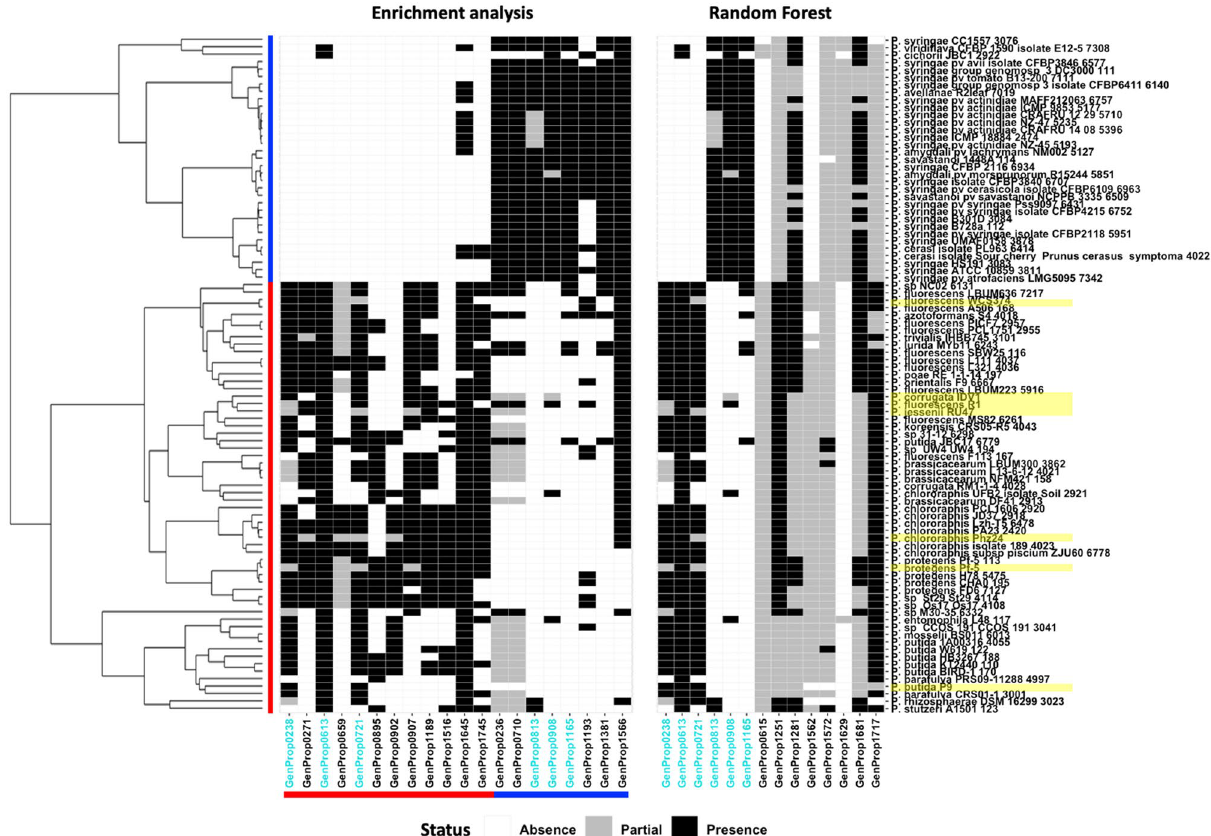
Figure 4. Representative list of discriminating Genome Properties obtained with the GP-SND approach. Left panel: enrichment analysis, right panel: Random Forest feature selection. Red lines indicate the PGPR strains (vertical) and enriched traits (horizontal). Blue lines indicate the EPP strains (vertical) and enriched traits (horizontal). Newly sequenced strains are highlighted in yellow. Enriched GPs that were also highlighted in the RF feature importance analysis are indicated in